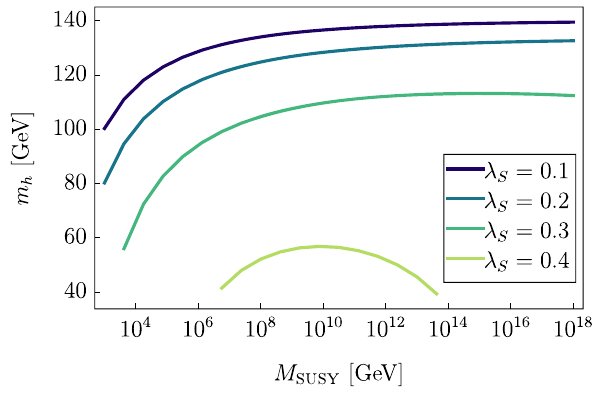
Fig. 12 The Higgs boson mass in a high-scale SUSY scenario based on the NMSSM with fixed tan β = 4. All SUSY fields including the singletsare(nearly)degeneratewithamassof M SUSY .Thegivenvalues of λ S determine the coupling strength of the gauge singlet and the two Higgs doublets in the NMSSM at the matching scale